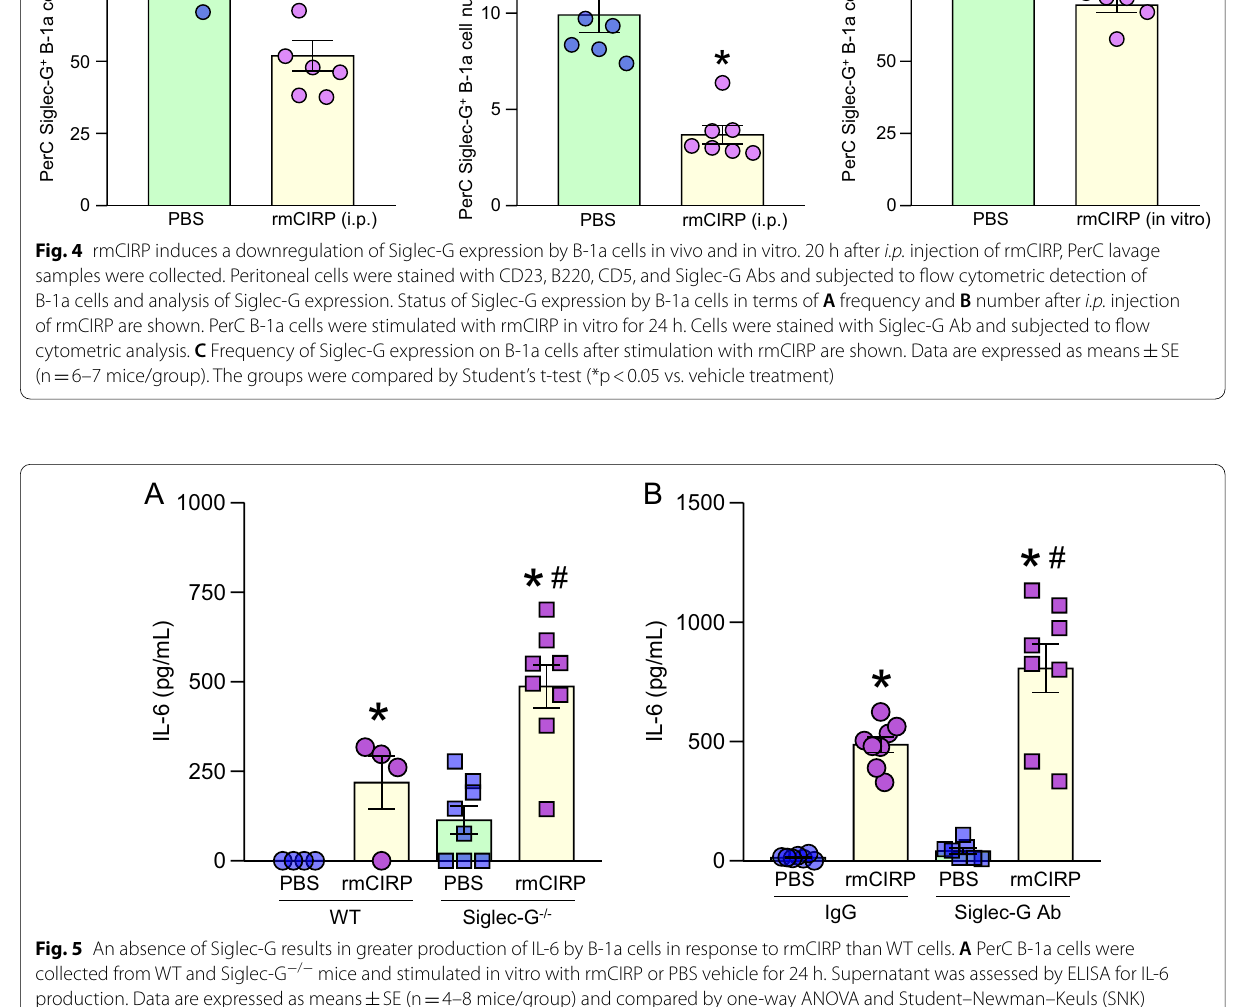
and isotype IgG as control. We found that pre-treat- ment of PerC B-1a cells with anti-Siglec-G Ab signifi- cantly increased the release of IL-6 compared to the isotype IgG control pre-treated PerC B-1a cells after stimulation of the cells with rmCIRP (Fig. 5B). These data suggest that genetic deletion and pharmacologic neutralization of Siglec-G result in significant increase